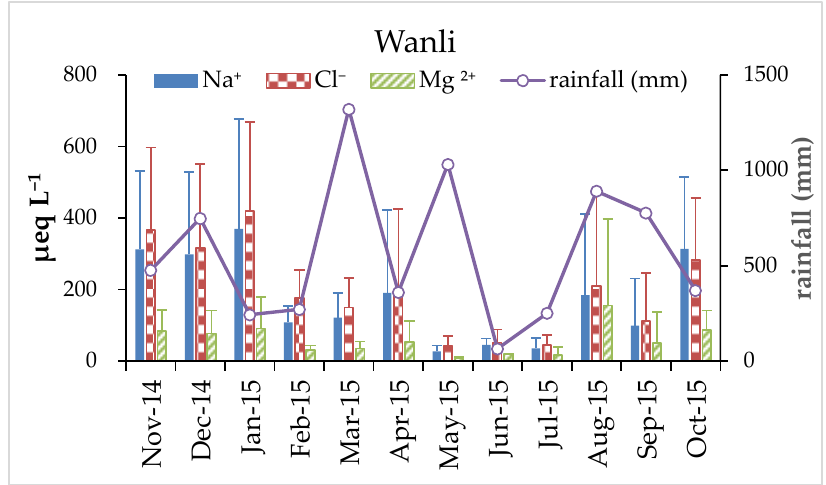
Figure 3. Volume weighted means of major ions in precipitation around East Asia.